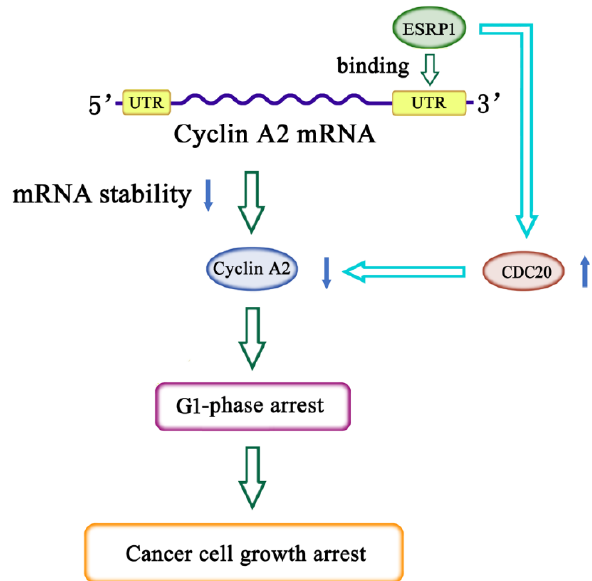
Figure 6. Model of ESRP1-mediated cell cycle G1-phase arrest. ESRP1 directly binds to the cyclin A2 mRNA 3′ UTR, which decreases the stability of the cyclin A2 mRNA and downregulates cyclin A2 protein levels. Furthermore, ESRP1 can upregulate the expression of CDC20, which leads to further downregulation of cyclin A2 expression via the APC CDC20 -mediated ubiquitin degradation pathway in HeLa cells.